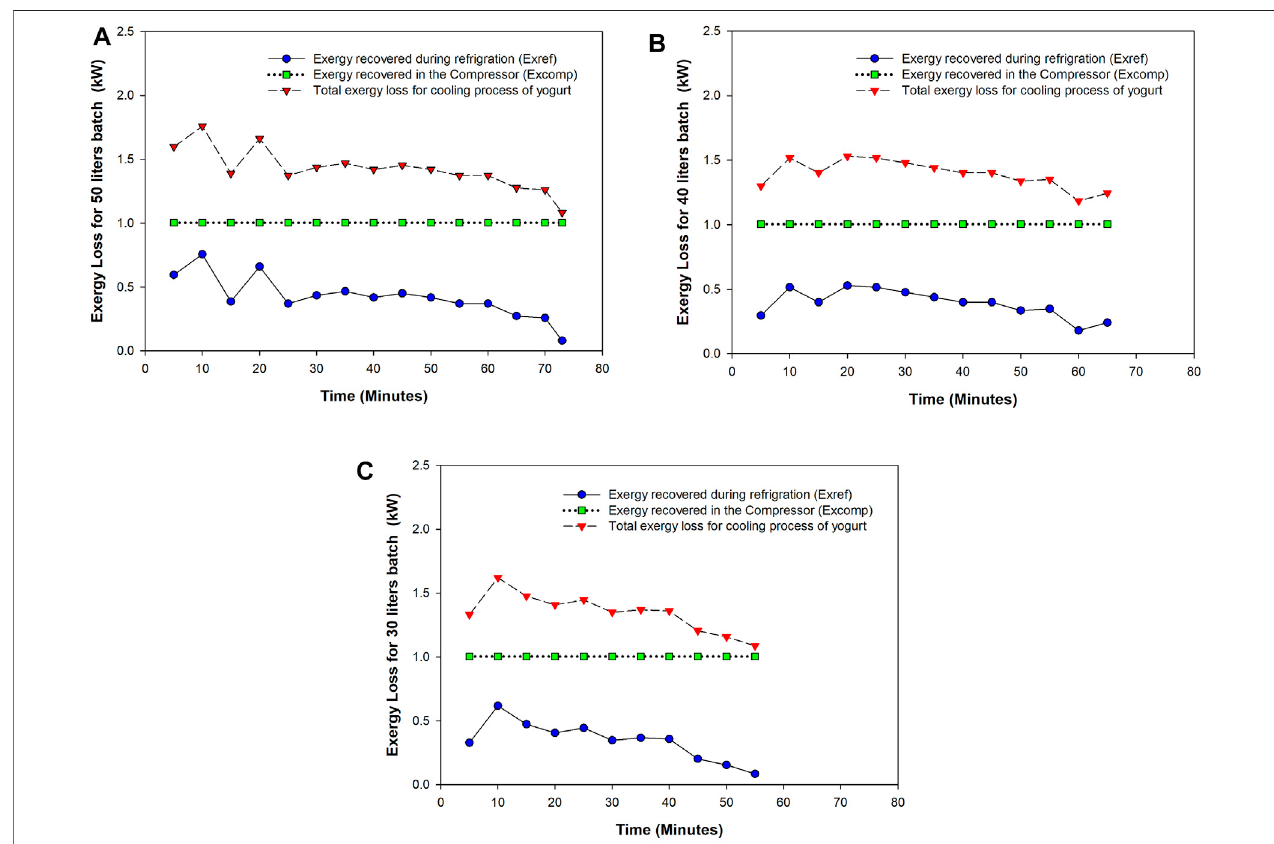
FIGURE 5 | Exergy losses in refrigeration unit and cooling of yogurt for 50 L (A) , 40 L (B) , and 30 L (C) batch capacities.